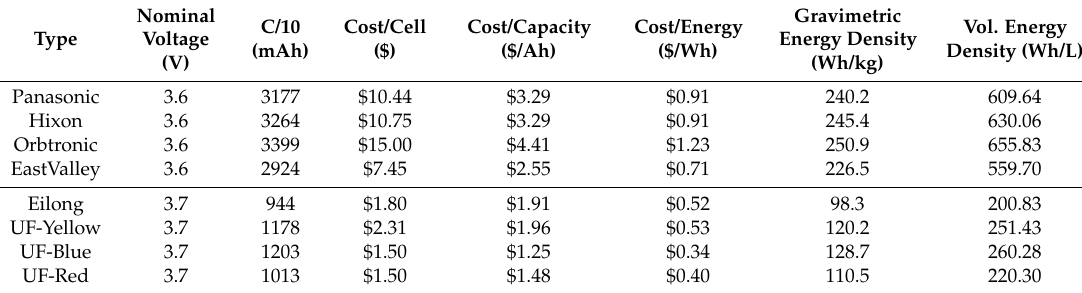
Table 5. Cost comparisons of cells based on C/10 discharge